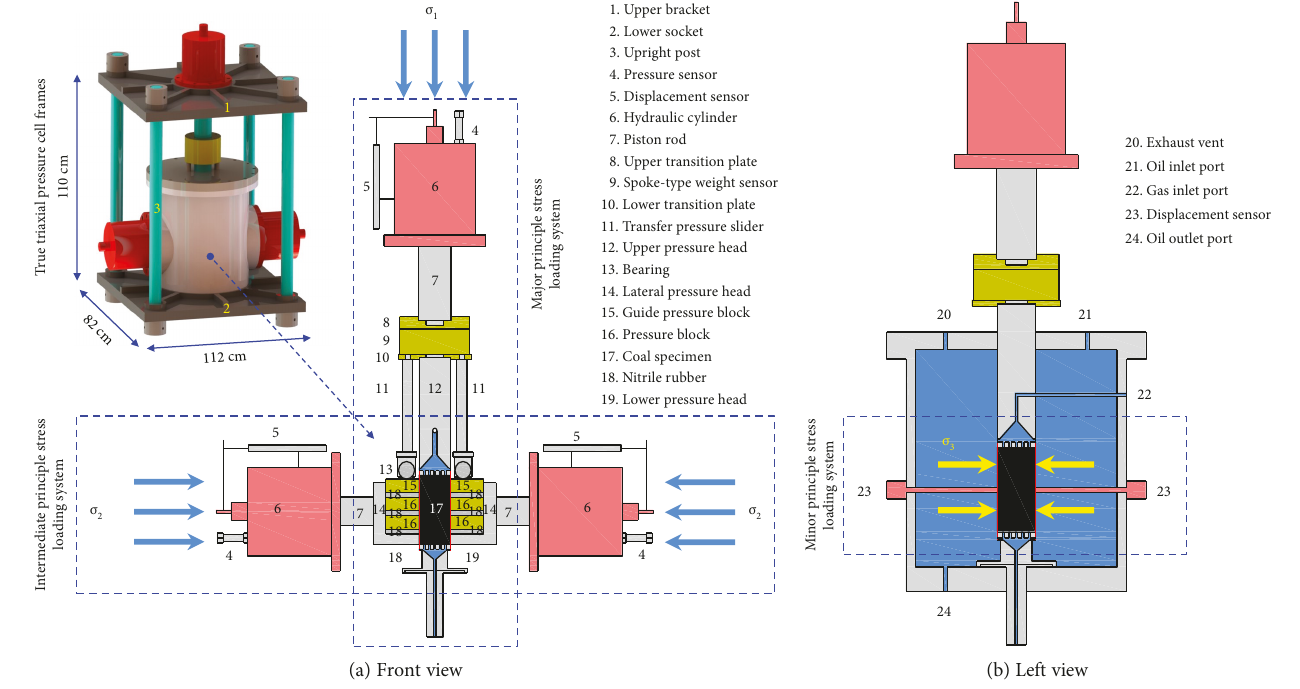
Figure 2: Schematic diagram of the true triaxial pressure cell.